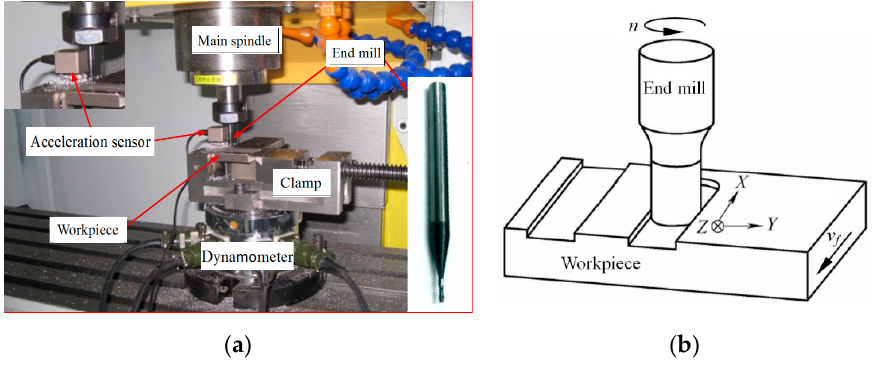
Figure 1. ( a ) Test setup. ( b ) coordinate system for micro-end-milling.